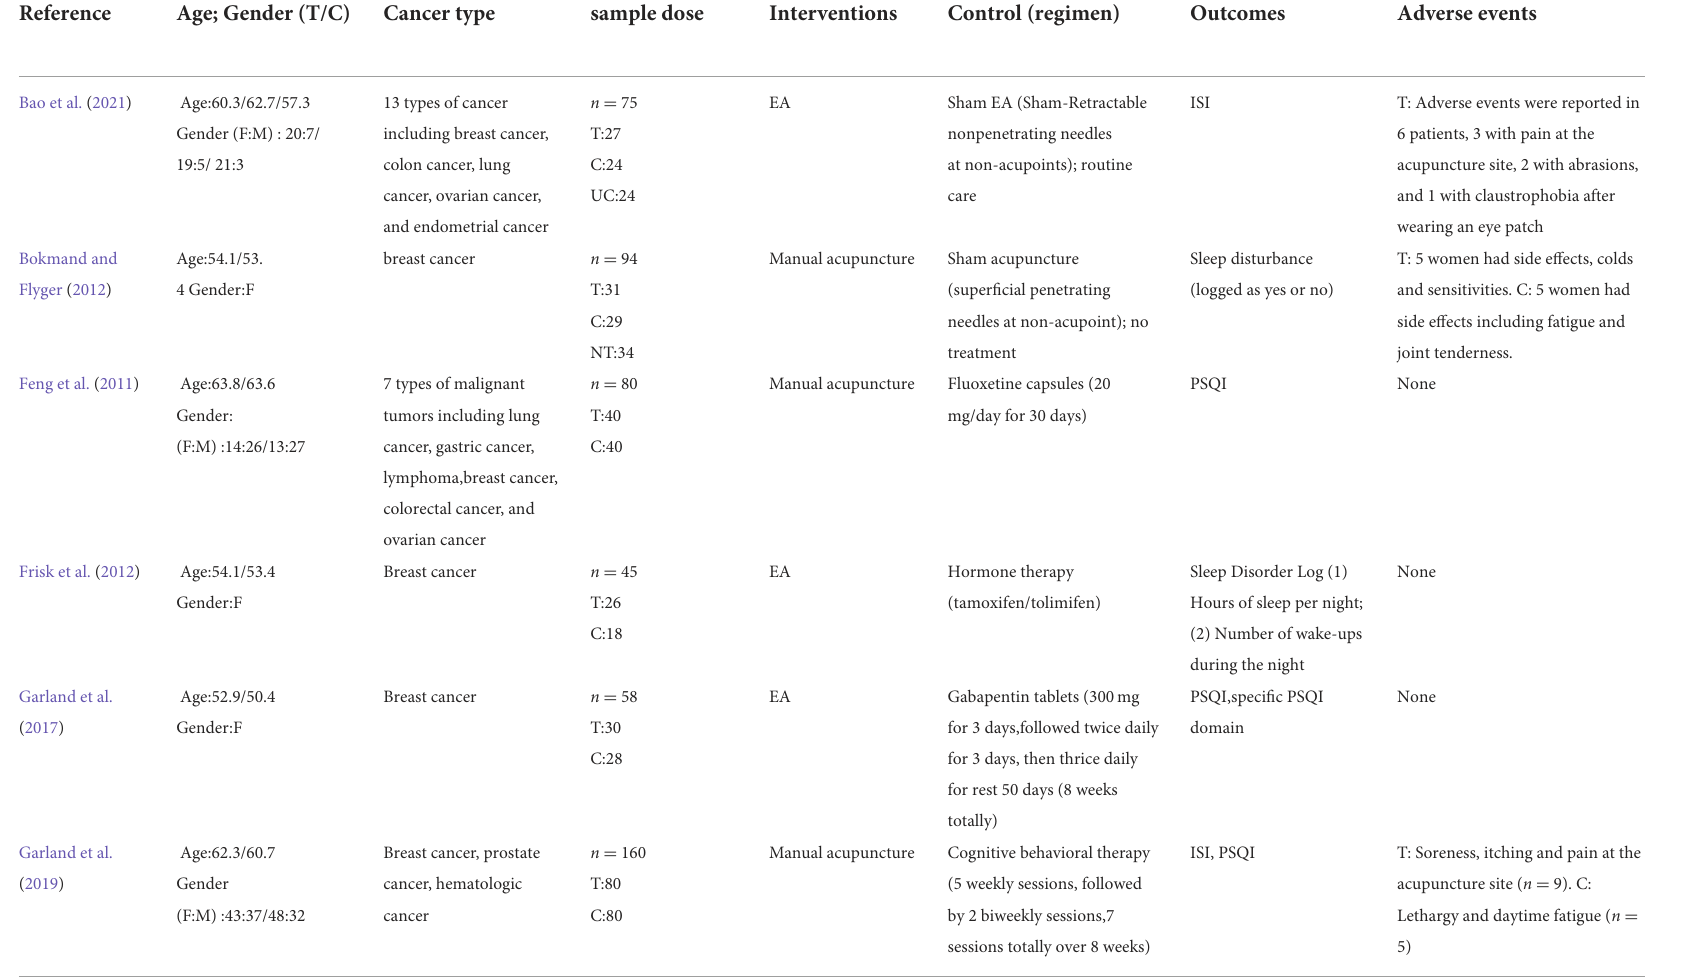
TABLE 1 Basic information of the included